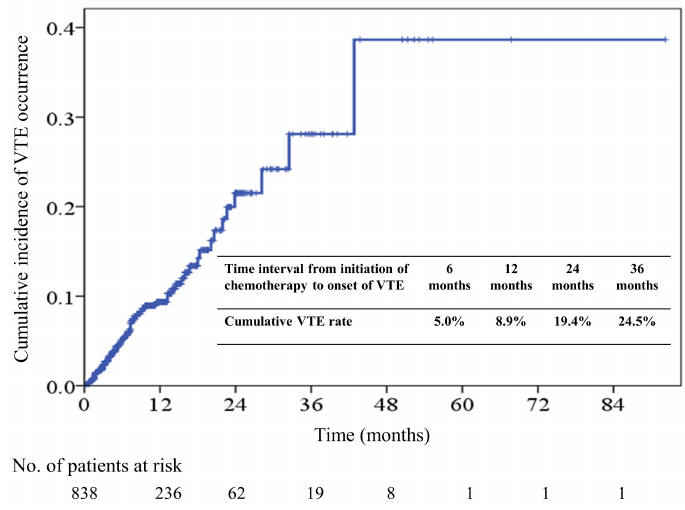
Figure 1. Cumulative incidence of Venous Thromboembolism (VTE) in all patients.